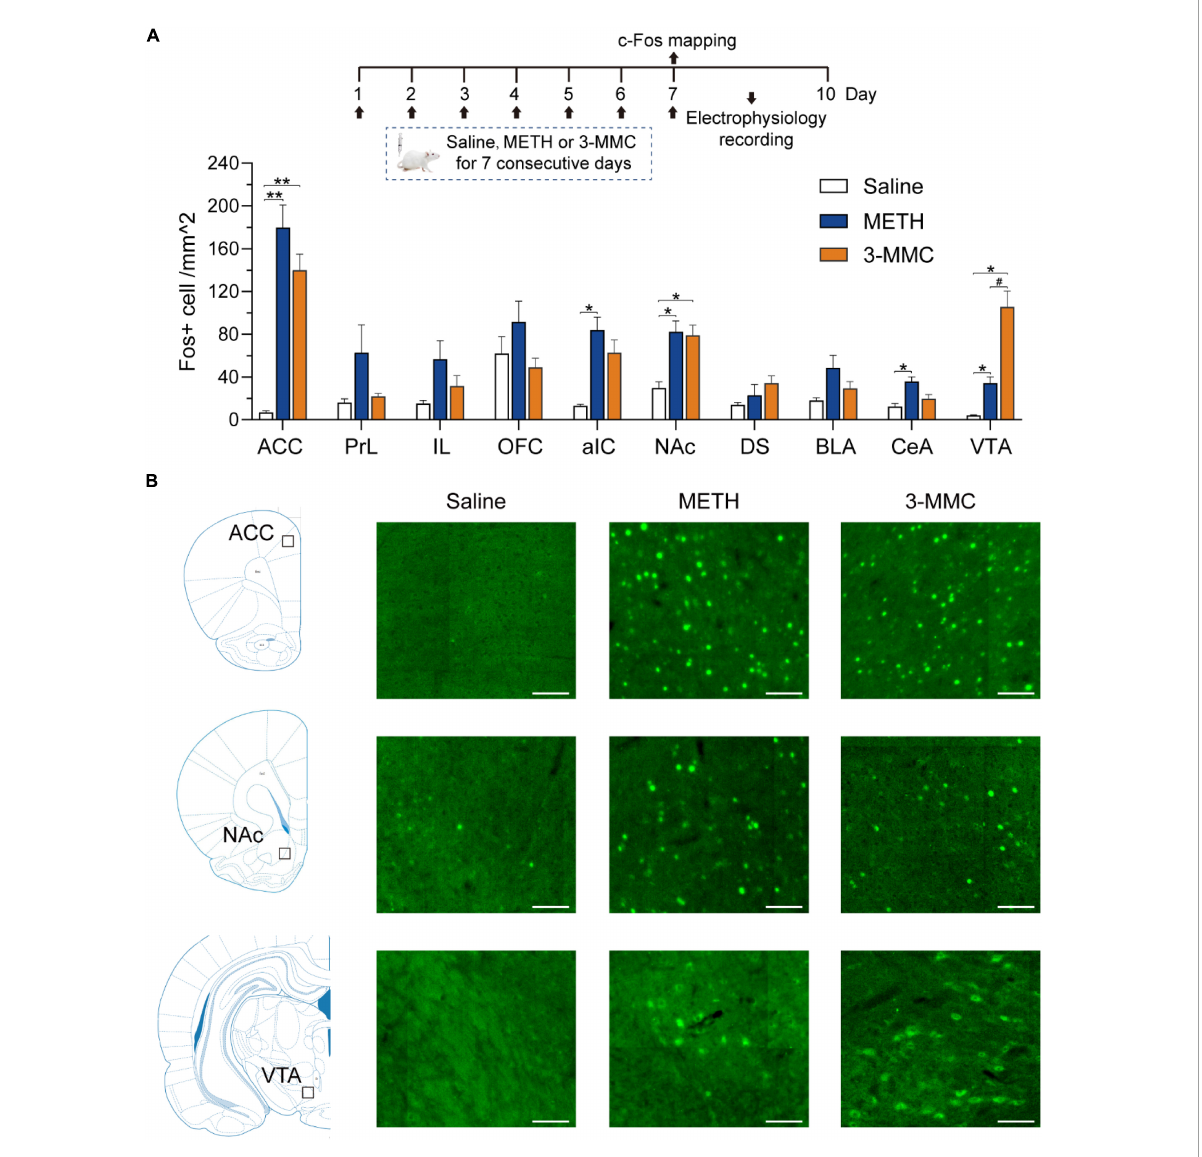
FIGURE3 Specific brain regions response to chronic 3-MMC exposure. (A) The c-Fos expression of rats 90 min after last injection of drugs, post hoc test, * P < 0.05, ** P < 0.01 significant differences for 3-MMC vs saline or METH vs saline, # P < 0.05 significant differences for 3-MMC vs METH, n = 4 for each group. (B) Representative immunofluorescent images of c-Fos expression in ACC, NAc, and VTA. Scale bar, 100 µ m. ACC, anterior cingulate cortex; PrL, prelimbic cortex; IL, infralimbic cortex; OFC, orbitofrontal cortex; aIC, anterior insular cortex; NAc, nucleus accumbens; DS, dorsal striatum; BLA, basolateral amygdala; CeA, central amygdala; VTA, ventral tegmental area. Data are presented as mean values ±